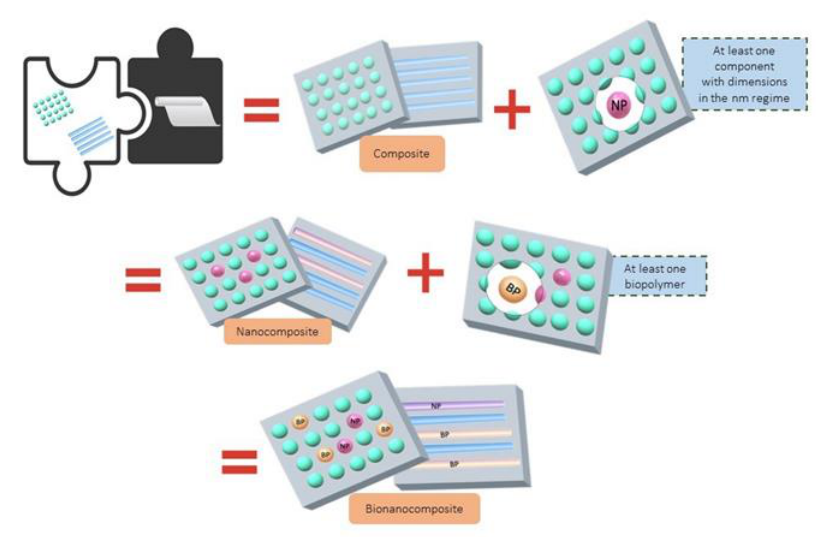
Figure 1. Bionanocomposites: Polymeric materials produced by bioprocesses (plants or microorgan- isms) based on nanostructure of materials derived from self-organization.